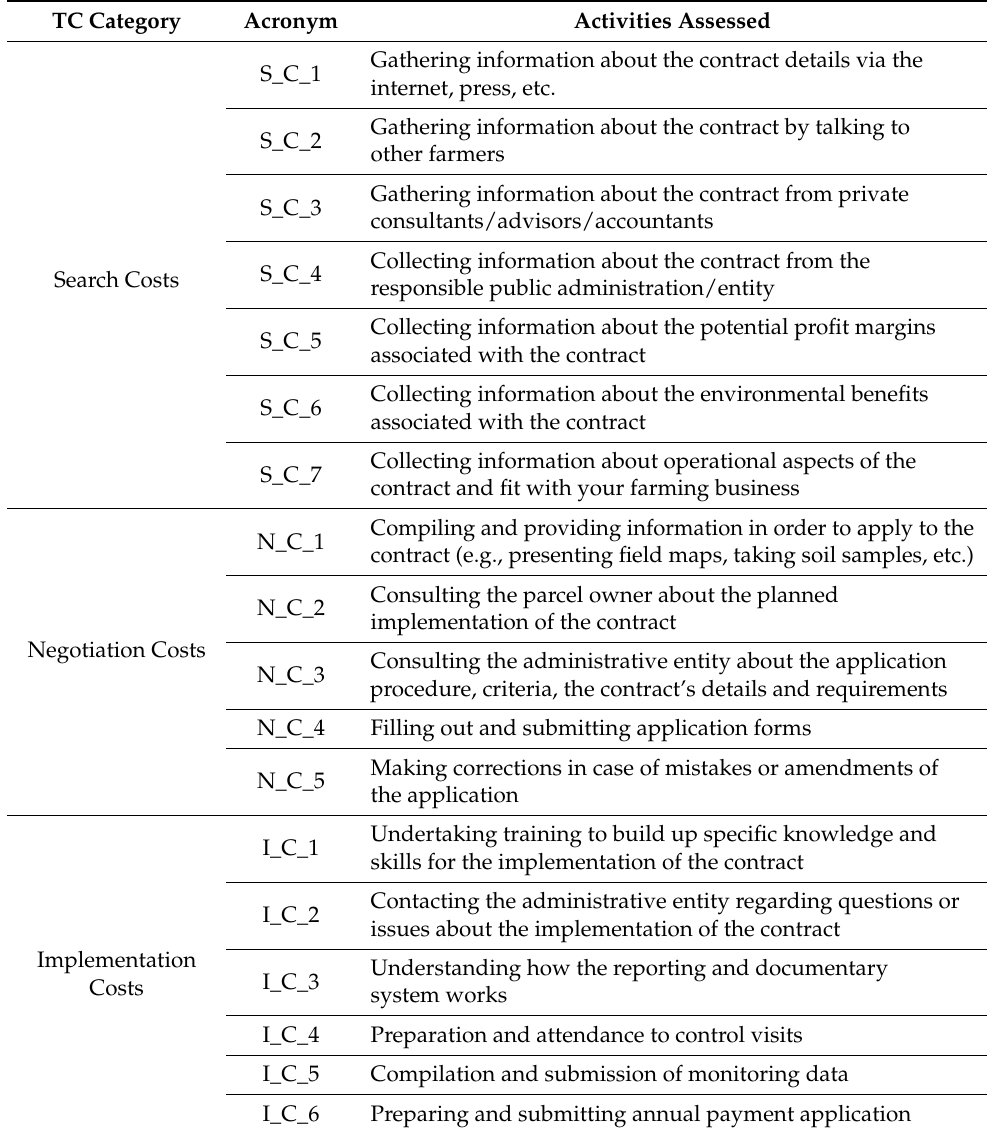
Table 2. Activities scored by the farmers interviewed (based on Mettepenningen et al. 2009; Coggan et al. 2010; McCann et al. 2005; Ansell et al.